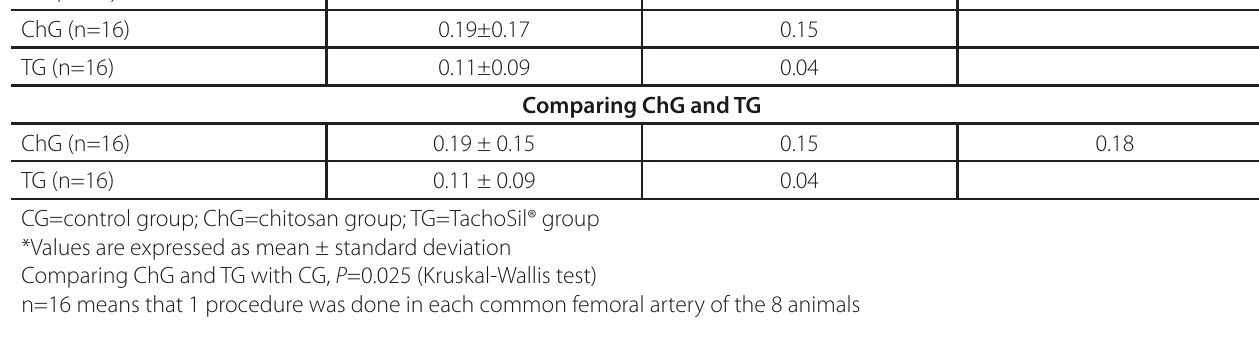
Table 2. Blood volume lost during haemorrhage in grams. Group